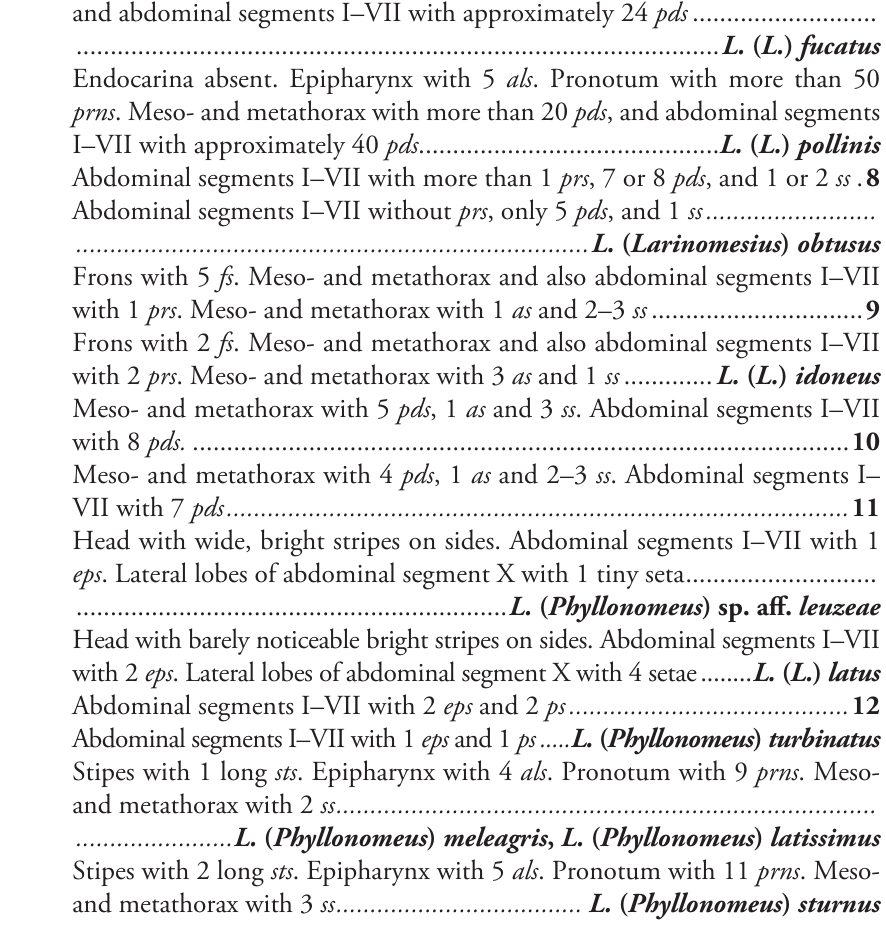
Stipes with 2 long sts . Epipharynx with 5 als . Pronotum with 11 prns . Meso- and metathorax with 3 ss .................................... L. ( Phyllonomeus ) sturnus